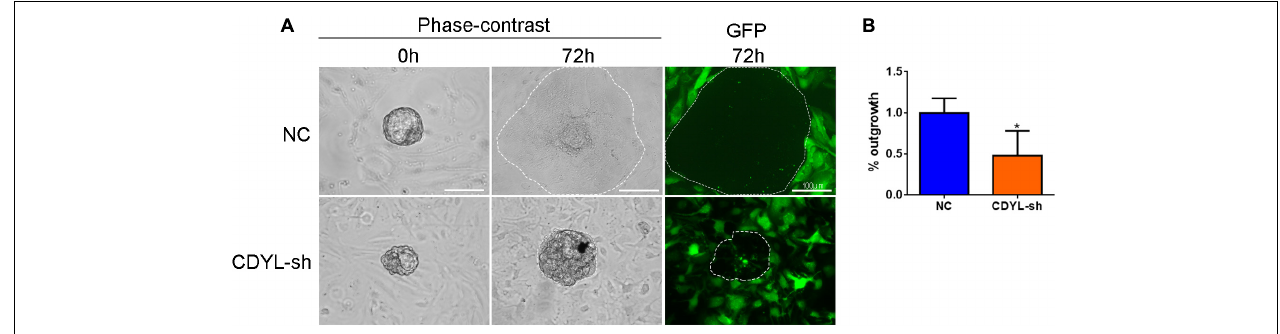
FIGURE 10 | CDYL knockdown in ESCs inhibited the trophoblast outgrowth in vitro. (A) Representative images showing the spreading mouse trophoblast (dotted line) that co-cultured on control or CDYL -sh ESCs. (B) Quantification of the area of outgrowth. N = 4, mean value of control group was set to 100%. Data are presented as mean ± SD. * P <